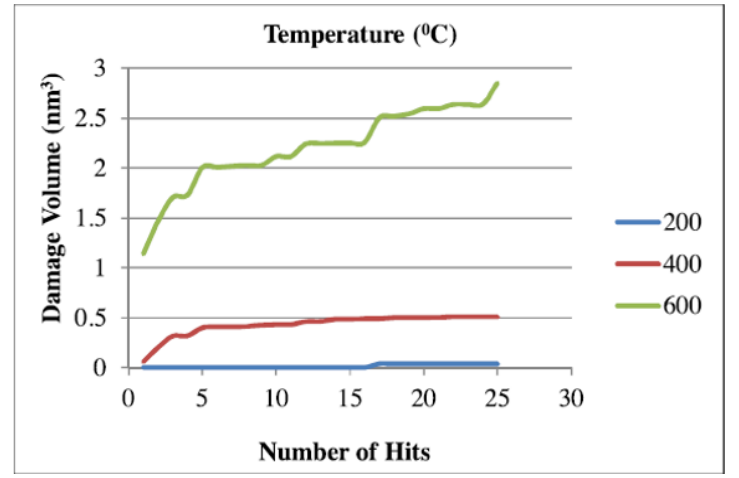
Figure 50. Effect of the number of hits in the variation of the damaged volume [247].